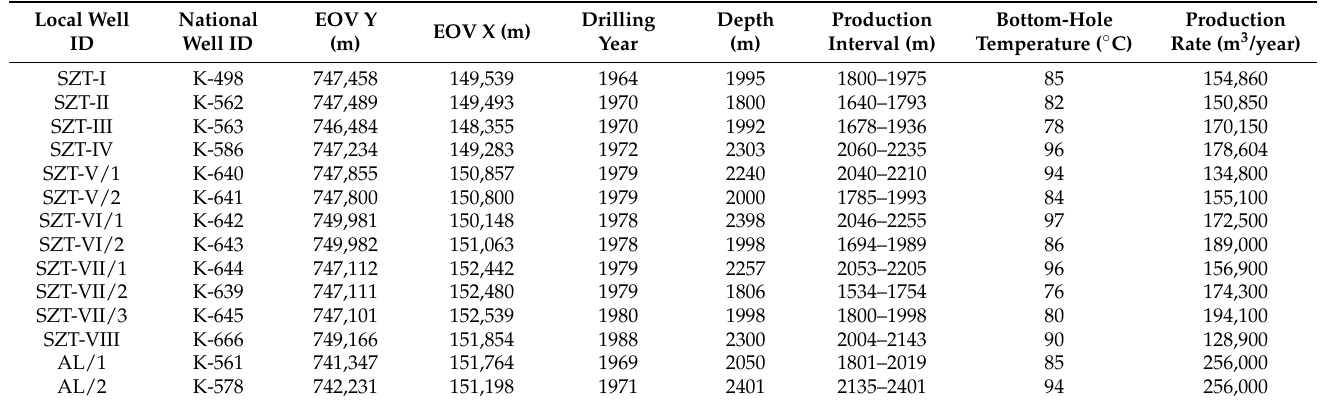
Figure 5. Stratigraphic cross-section across the study area with wells and their production (screen) interval. The section path illustrated is in Figure 1. The wells “SZT-1” and “SZSZT-IX” were drilled within the framework of this study (modified after [1,28]). Table 1. Characteristics of wells close to “SZT-1” and “SZSZT-IX” located in Szentes (based on Bálint and Szanyi [1]).